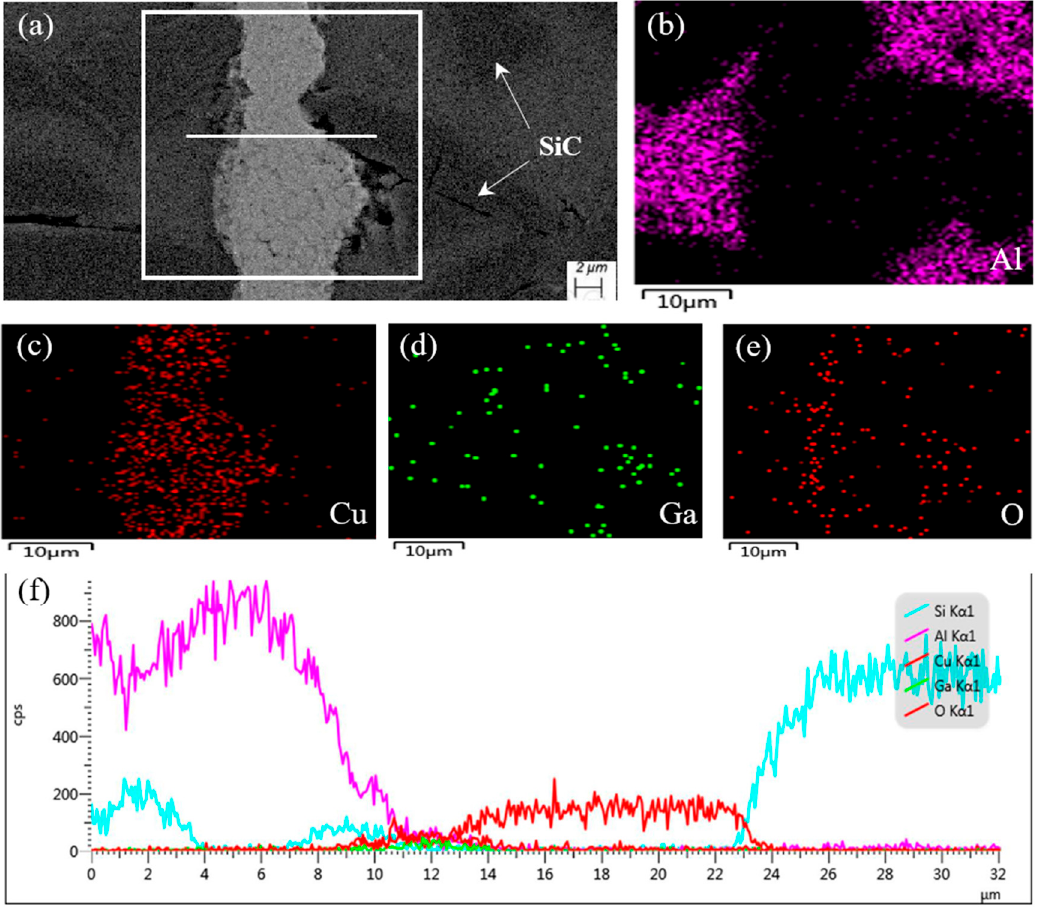
Figure 7. SEM image of typical region at the interface of the 65 vol.% SiC p /6063 Al MMC joint made at 450 °C and corresponding energy dispersive X-ray maps showing distribution of elements: ( a ) SEM image; ( b – e ) individual elemental mapping of Al, Cu, Ga, and O, respectively; ( f ) line scanning profile.